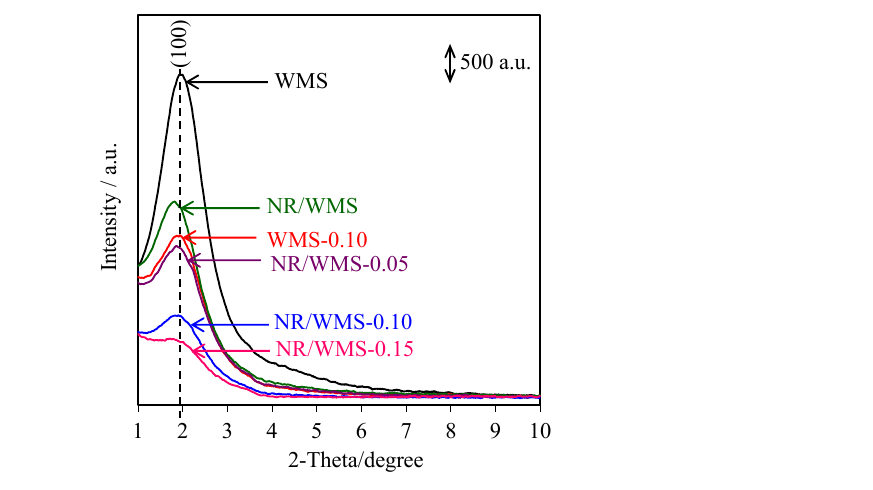
Figure 4. XRD patterns of the WMS and NR/WMS functionalized with different amine loadings.